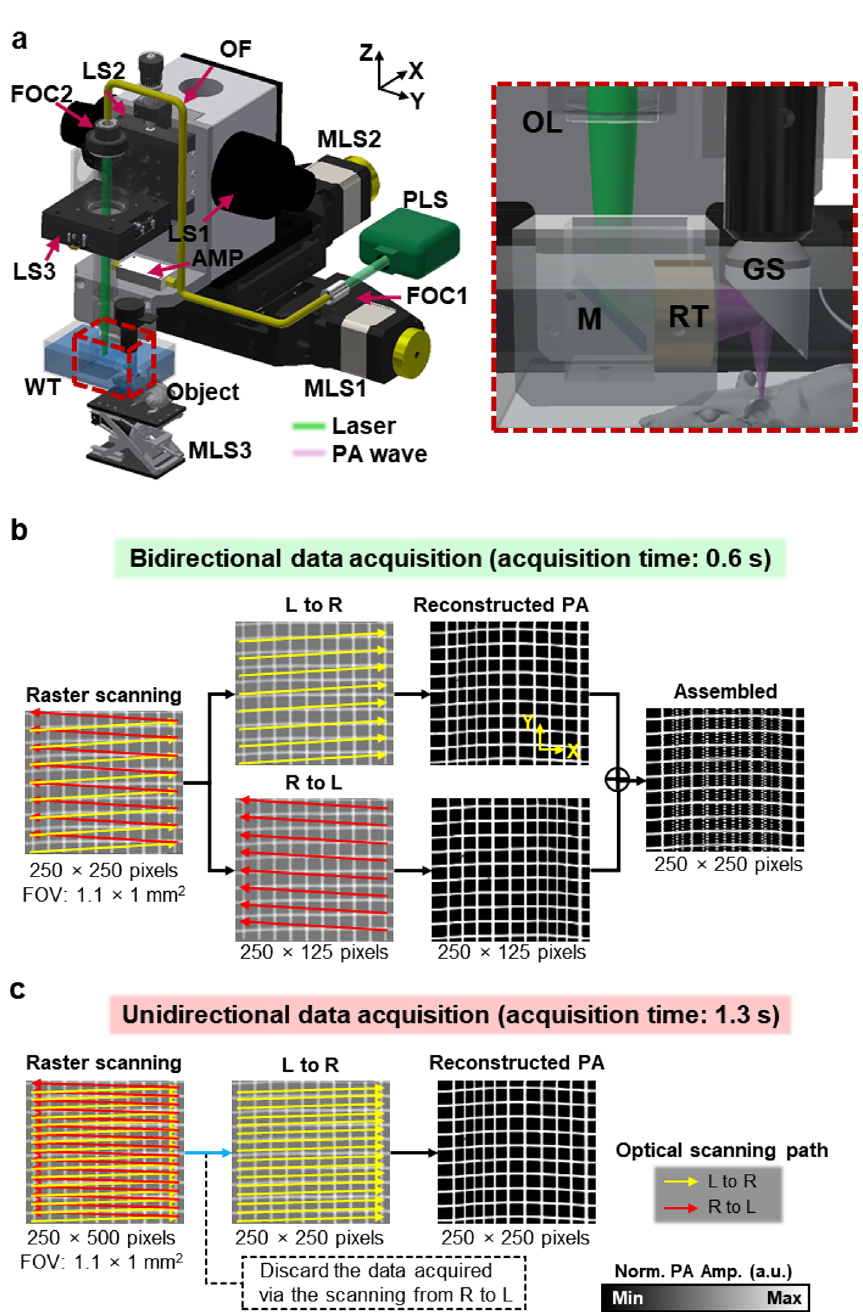
Figure 1. ( a ) Configuration of an optical-resolution photoacoustic microscopy (OR-PAM) system. Scanning and imaging acquisition scenarios with ( b ) bidirectional and ( c ) unidirectional raster scanning. OF, optical fiber; LS, linear stage; FOC, fiber optic collimator; MLS, motorized linear stage; PLS, pulsed laser system; AMP, amplifier; WT, water tank; OL, objective lens; RT, ring transducer; GS, galvanometer scanner; M, mirror; L, left; R, right; FOV, field of view; PA, photoacoustic; and Norm. PA Amp., normalized photoacoustic